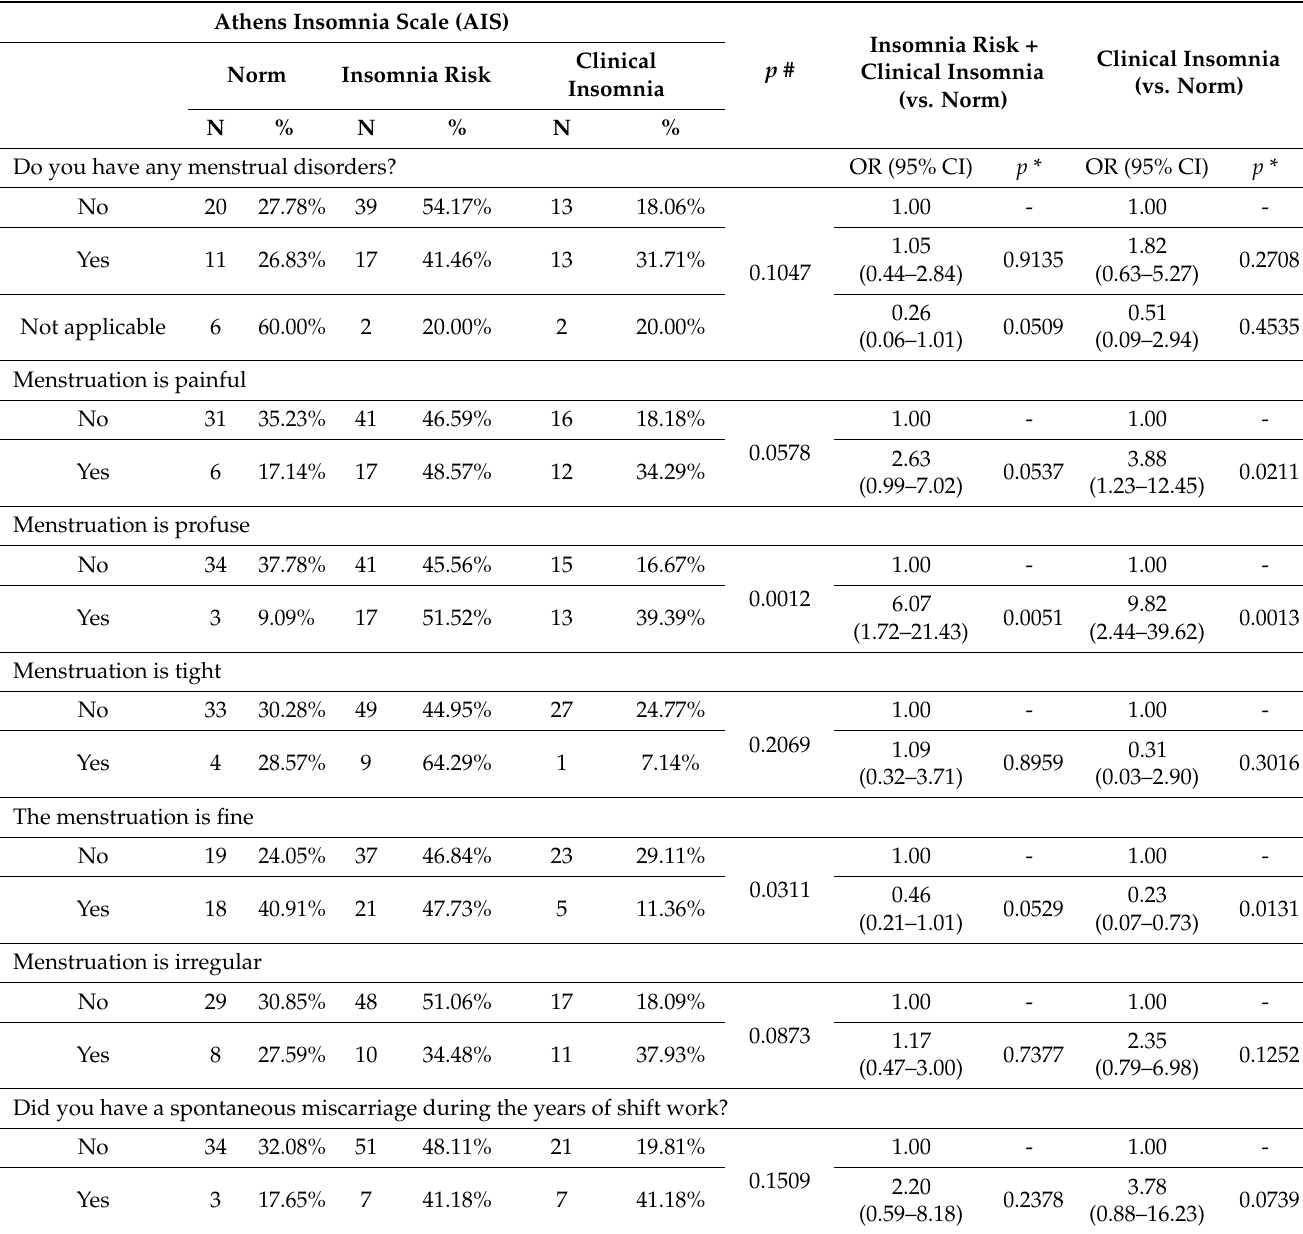
Table 11. Menstrual disorders and sleep disorders in nurses (analysis made only for